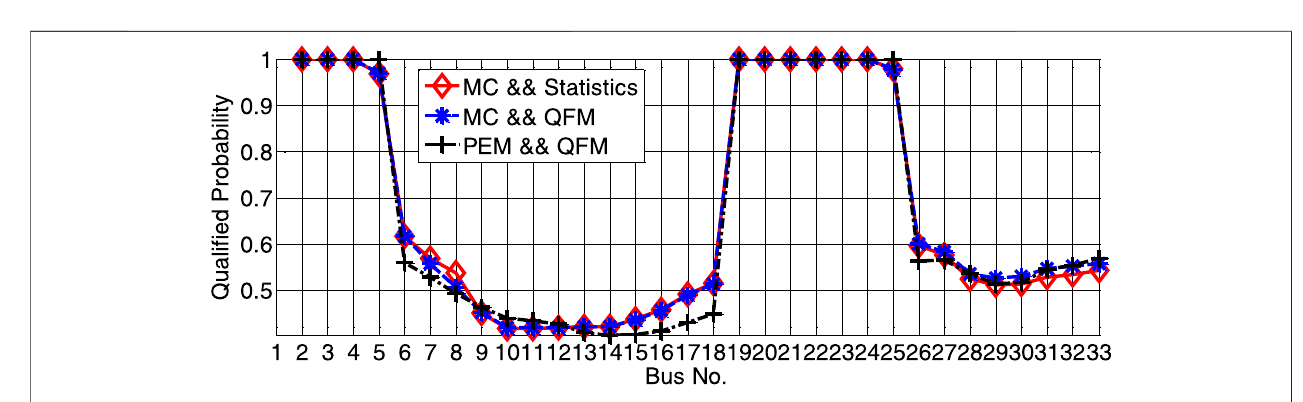
FIGURE 12 | Simulation results for the quali fi ed probability of the voltage